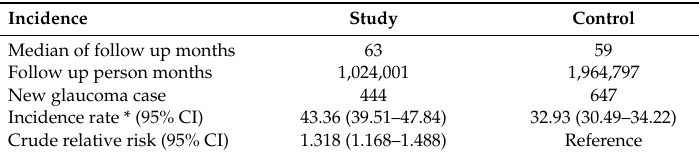
Table 2. Incidence of glaucoma in the study and control groups.